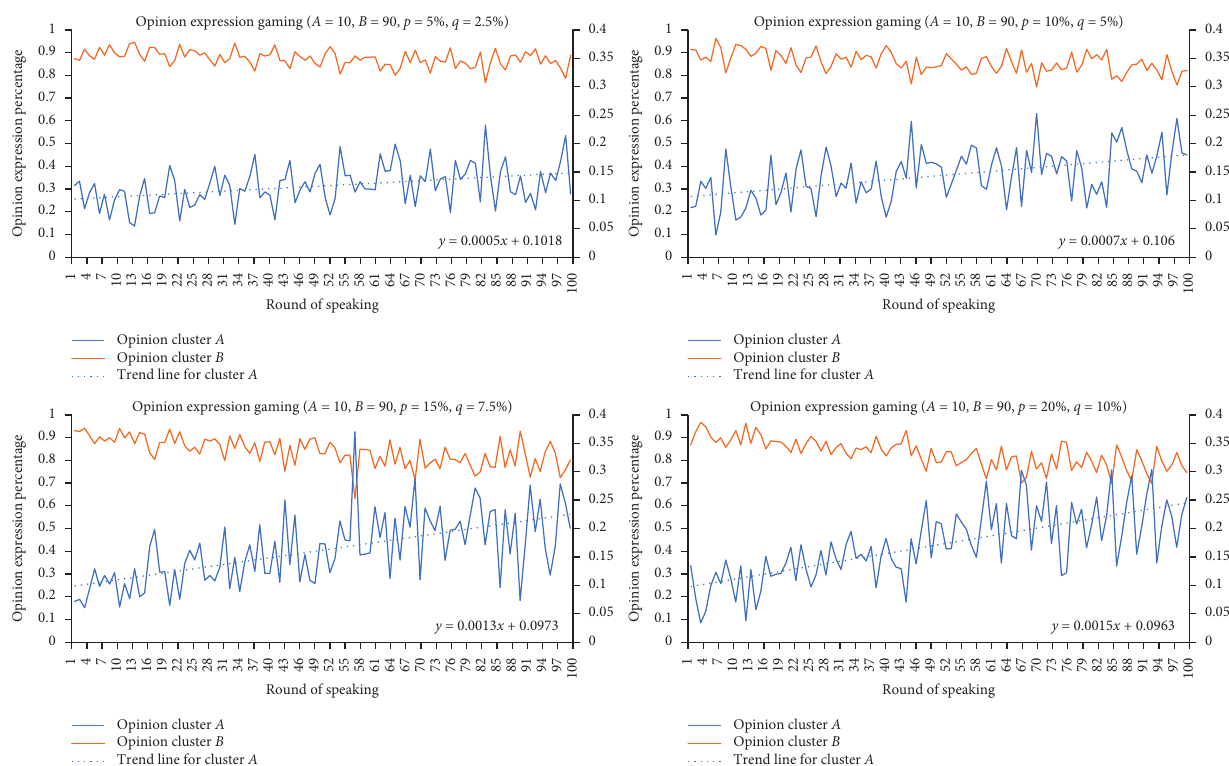
Figure 4: Minority/majority opinion expression. (For example, A � 10, B � 90). Note. Opinion expression percentage, with A (minority cluster) � blue thick line and B (majority cluster) � red thin line. Round of speaking represents time because each discussion allows 100 rounds of speaking. All the results were shown in the average score of 100 times’ simulation.